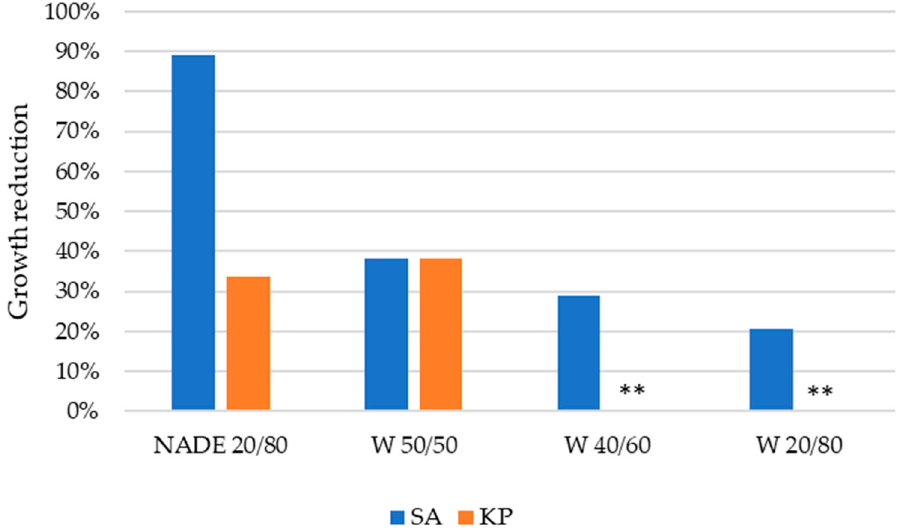
Figure 9. Growth reduction (%) of the S. aureus (SA) and K. pneumoniae (KP) bacteria obtained for the nanofibers produced. **—unable to measure.